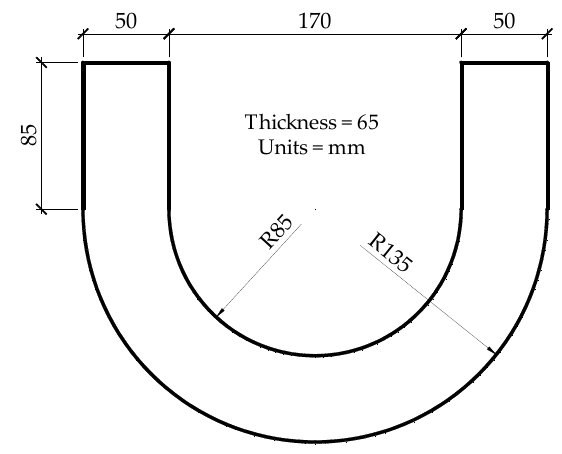
Figure 2. U-Shape specimen for the drop weight test.